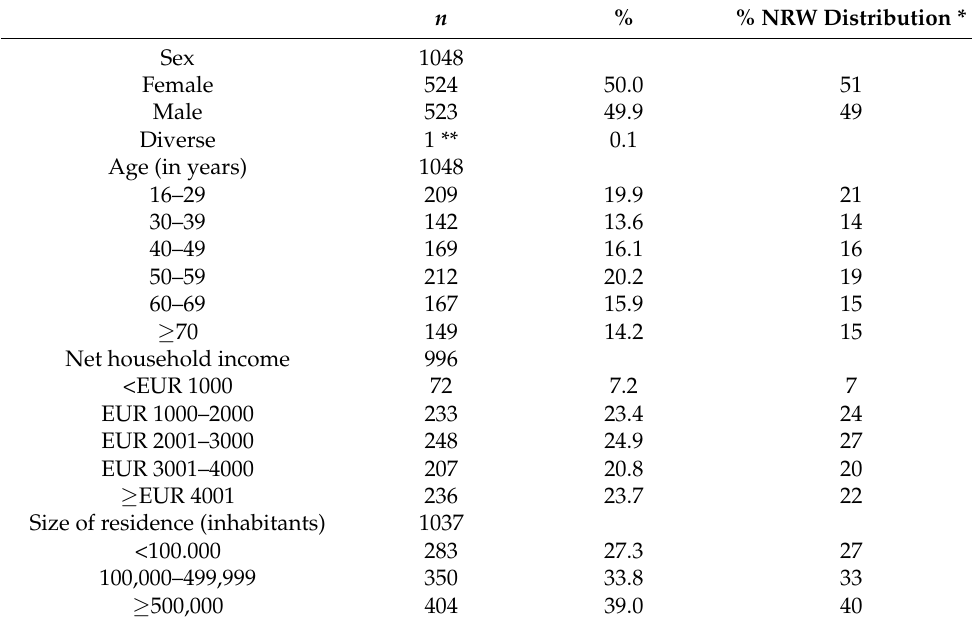
Table 2. Sample characteristics ( n = 1049) compared to the distribution in NRW